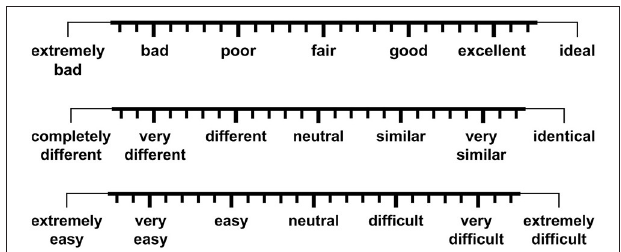
FIGURE 2 | Three continuous rating scales were employed for subjective assessment of perceived speech quality (top scale), speech intelligibility (top scale), voice similarity (middle scale), and talker-identification effort (bottom scale). A seven-point “extended continuous scale” design was implemented in accordance with ITU-T Recommendation P.851 (2003). Another version of this figure originally appeared in Uhrig et al. (2020a), copyright 2020, with permission from